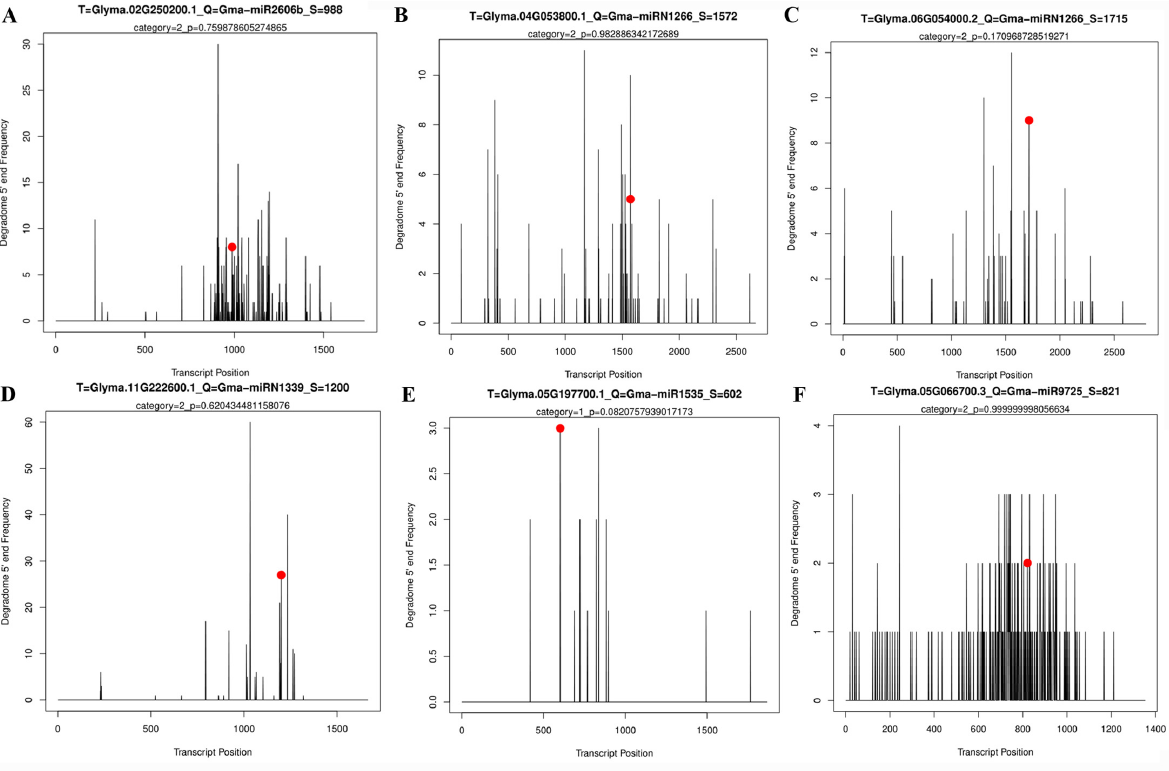
Figure 7. Post-transcriptional regulation of GmPP2C-A and GmSnRK2 by degradome sequencing. ( A ) Cleavage features in GmPP2C2 by Gma-miR2606b. ( B ) Cleavage features in GmPP2C3 by Gma- miR1266. ( C ) Cleavage features in GmPP2C5 by Gma-miR1266. ( D ) Cleavage features in GmPP2C9 by Gma-miRN1339. ( E ) Cleavage features in GmSnRK2.3 by Gma-miR1535. ( F ) Cleavage features in GmSnRK2.11 by Gma-miR9725. Vertical axes display the read abundance and the horizontal axes display the precursor position by base pair. The black vertical bars show the read abundance for the corresponding precursor base. The red dots mean the cleavage nucleotide positions on the target genes. The corresponding p values are shown above the plots.